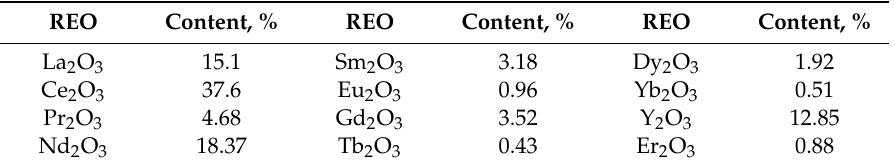
Table 2. Content of rare earth oxides (REO) in phosphoric acid solutions 2 .